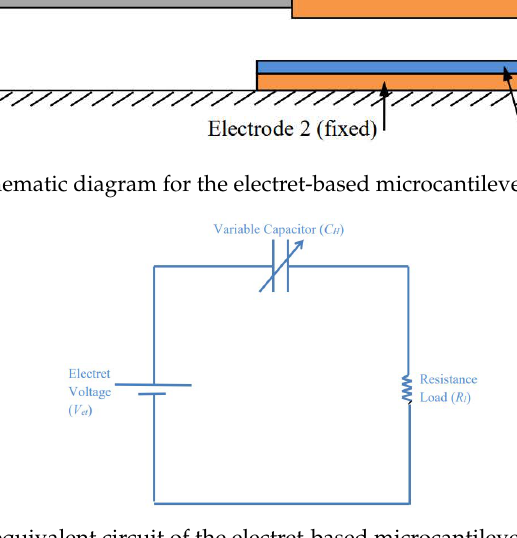
Figure 2. The equivalent circuit of the electret-based microcantilever energy